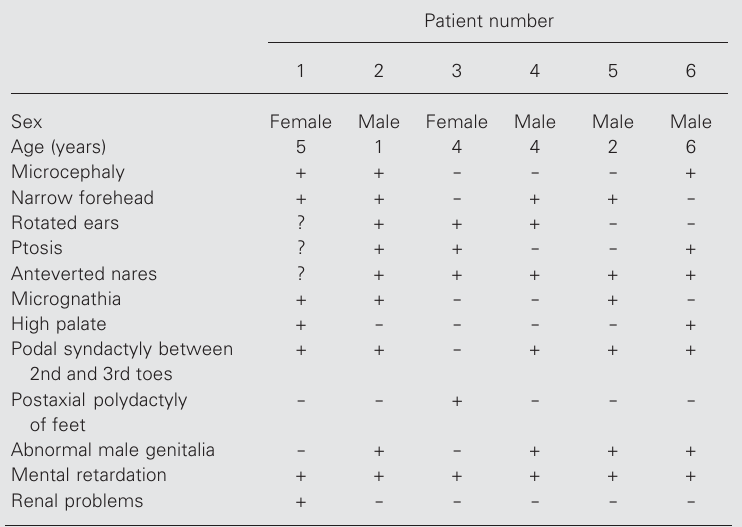
Table 1. Clinical characteristics of 6 patients with suspected Smith-Lemli-Opitz syn- drome.